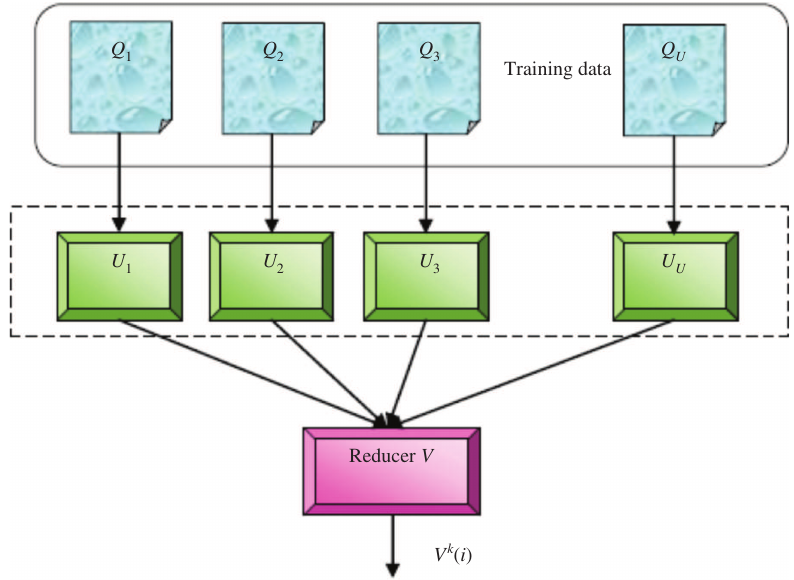
Figure 1: Training of the FCNB-Based MapReduce Framework.